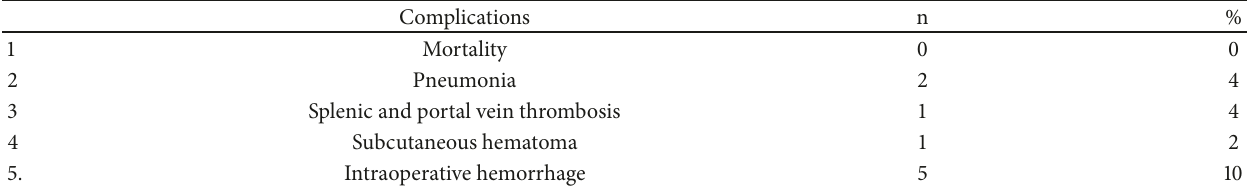
Table 2: Postoperative